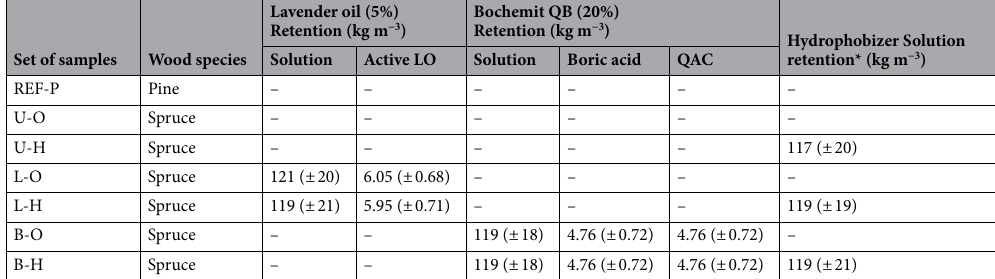
to a 14 days leaching procedure by EN 84 68 . The 3rd group of samples was subjected to artificial weathering in Xenotest based on standard EN 927-6 69 . The following parameters were set in the Xenotest chamber: total exposure time 320 h (2.5 h irradiation and 0.5 h of spraying in the dark in one cycle); the set radiation intensity 55 W m −2 (T-UV between 300–400 nm); temperature on black panel 70 °C; air temperature 45 °C, relative air humidity 30%; the total energy of the radiation that fell on the test specimens 13,210 kJ m −2 . After aging proce- dures, the samples were again air-conditioned at w ≈ 12%.